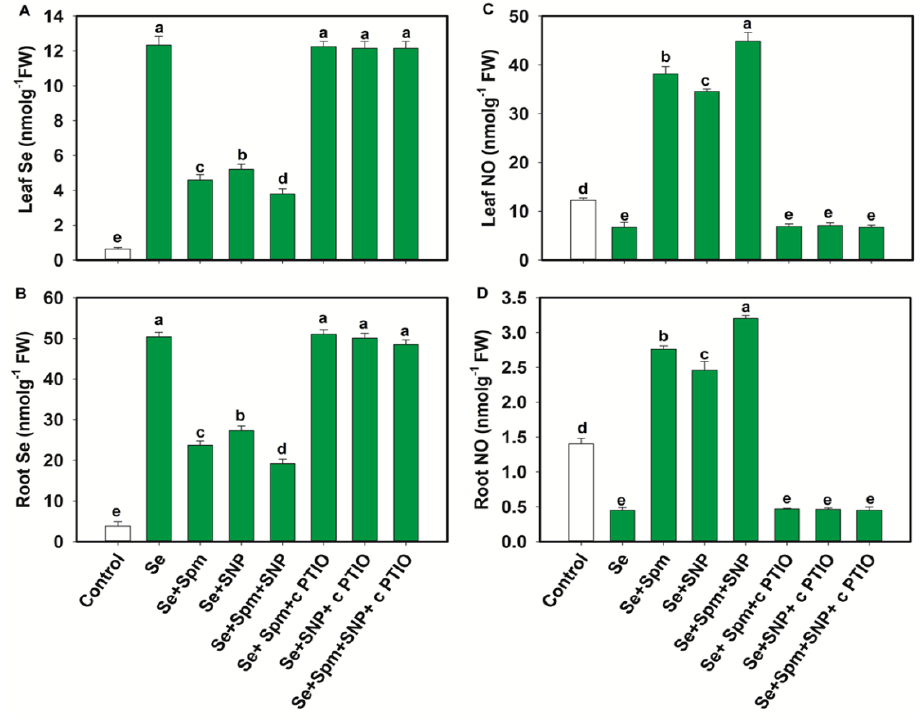
Figure 2. Selenium (Se) and NO contents ( A – D ) of leaves and roots of 49-day-old wheat plants grown under control and Se stress (1 mM) sprayed with 1.0 mM Spm or 0.1 mM SNP alone or together, combined with 0.1 mM cPTIO, a NO scavenger. Data presented are the mean (± SE) of three replicates, and bars with dissimilar letters (a–e) represent significantly different results at the p ≤ 0.05 level based on Fisher’s LSD test.